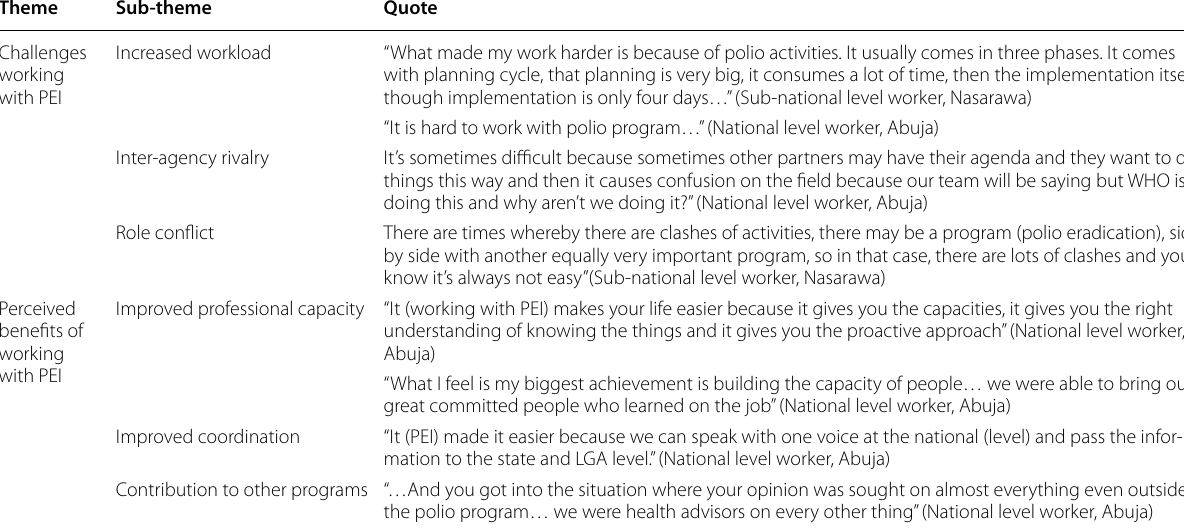
Table 2 Perceived challenges and benefits of working with PEI, according to sampled Nigerian health workers